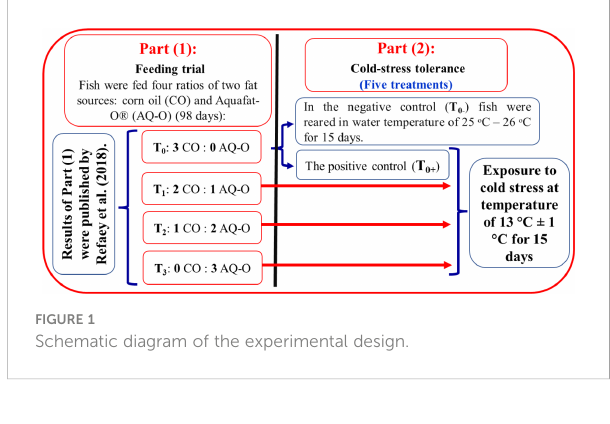
FIGURE 1 Schematic diagram of the experimental